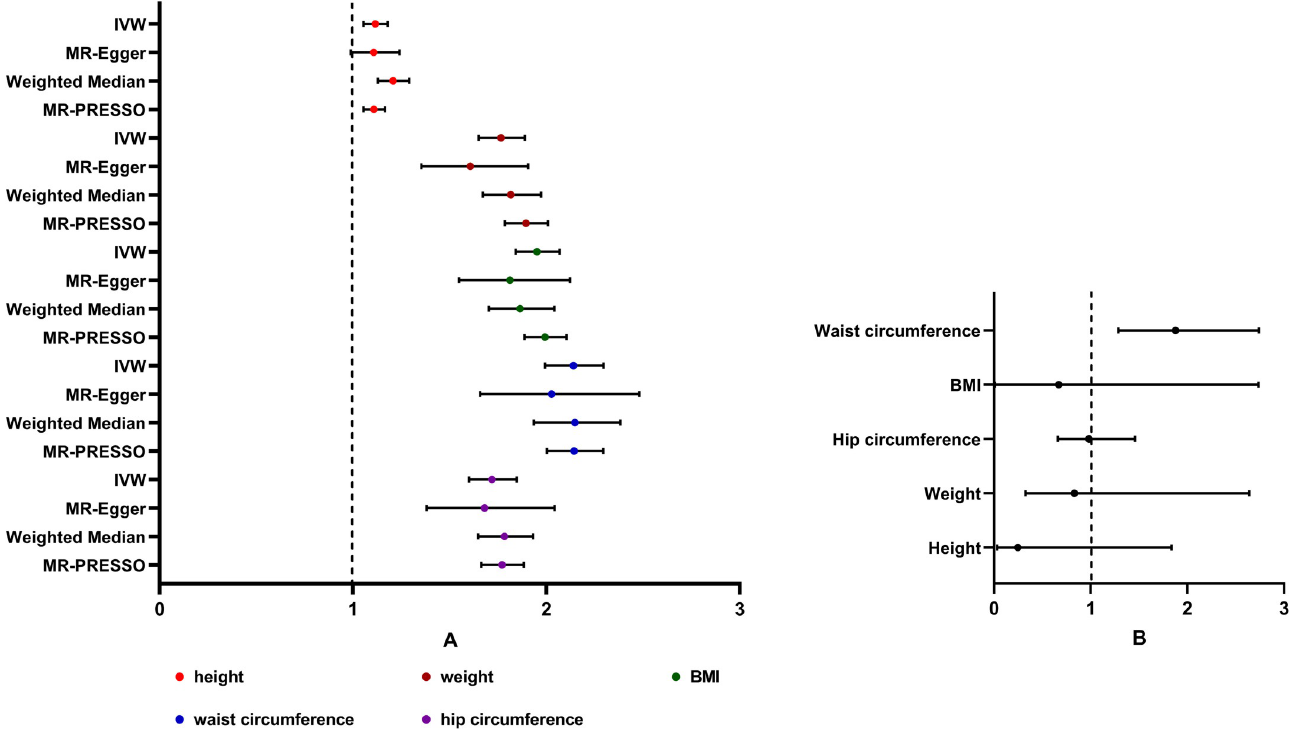
Fig 2. Forest plot for univariable and multivariable MR analyses of the causal effect of anthropometric measurements on osteoarthritis. A. Estimated causal effects of anthropometric measurements on osteoarthritis using univariable MR. The genetically predicted height, weight, BMI, waist circumference, and hip circumference are included. Inverse-variance weighted (IVW), MR-Egger, weighted median and MR-PRESSO represent different Mendelian randomization models. B. Estimated causal effects of anthropometric measurements on osteoarthritis using multivariable MR. MVMR results are from adjusting all 5 measurements together for OA